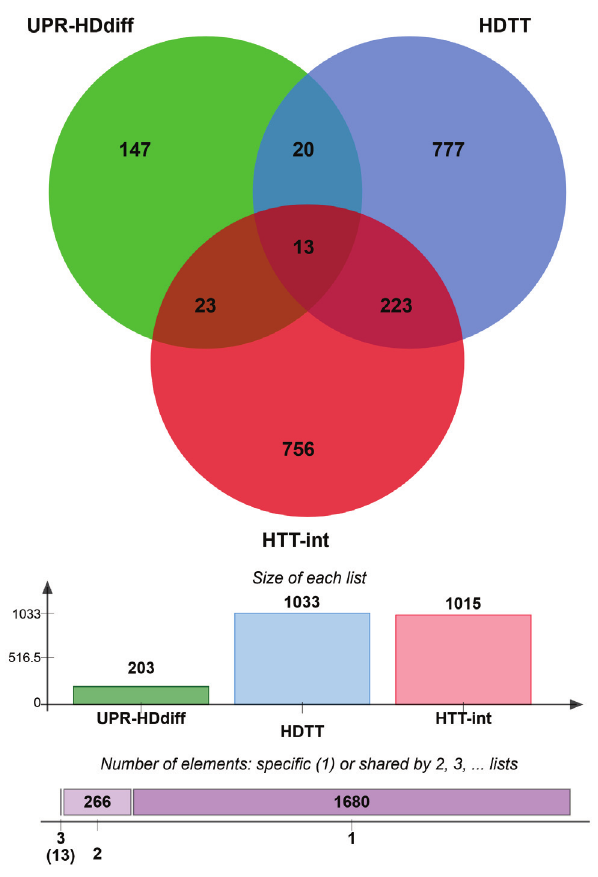
Supplementary Figure 4. UPR-HD connectors. Venn diagram showing common genes between 3 data sets, high stringency UPR-HD diff : UPR genes that are differentially regulated in HD i.e. either upregulated in human HD iPSC and 6 murine HD models or downregulated in 5 murine HD models; HDTT: HD therapeutic targets as described by Kalathur RK et al. 41 and originated by the HDCrossRoads database; and HTT-int: HTT interactors derived from the HDNetDB.